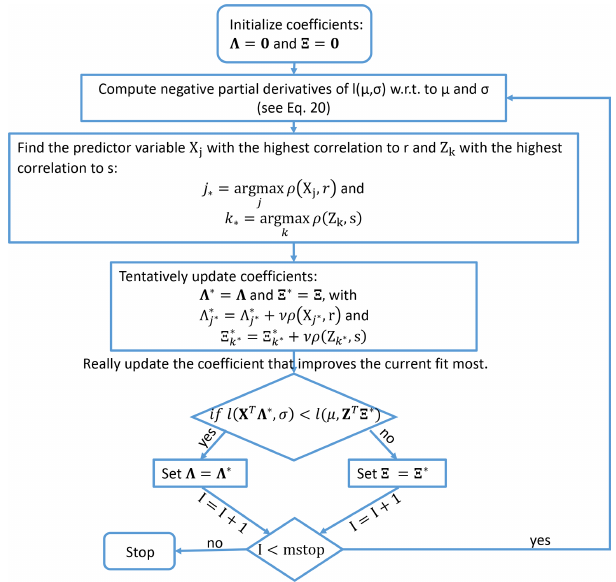
Figure 3. Schematic flow chart for boosting algorithm proposed by Messner et al. (2016). For the ensemble mean and the ensem- ble variance, we use the expressions µ Cal,boost (t,τ) = X T (cid:51) and ln (σ 2 Cal,boost )(t,τ) = Z T (cid:52) , where X = ( 1 ,X 1 ,X 2 ,...) T and Z = ( 1 ,Z 1 ,Z 2 ,...) T are vectors of predictor terms and (cid:51) = (a 0 ,b 0 ,a 1 ,b 1 ,...) and (cid:52) = (c 0 ,d 0 ,c 1 ,d 1 ,...) are vectors of the corresponding coefficients. Here, 0 is a vector of zeros, mstop is the predefined maximum number of boosting iteration steps I and ρ(X j ,r) as well as ρ(Z k ,s) are the correlation coefficients calcu- lated by X j × r and Z k × s over the respective training